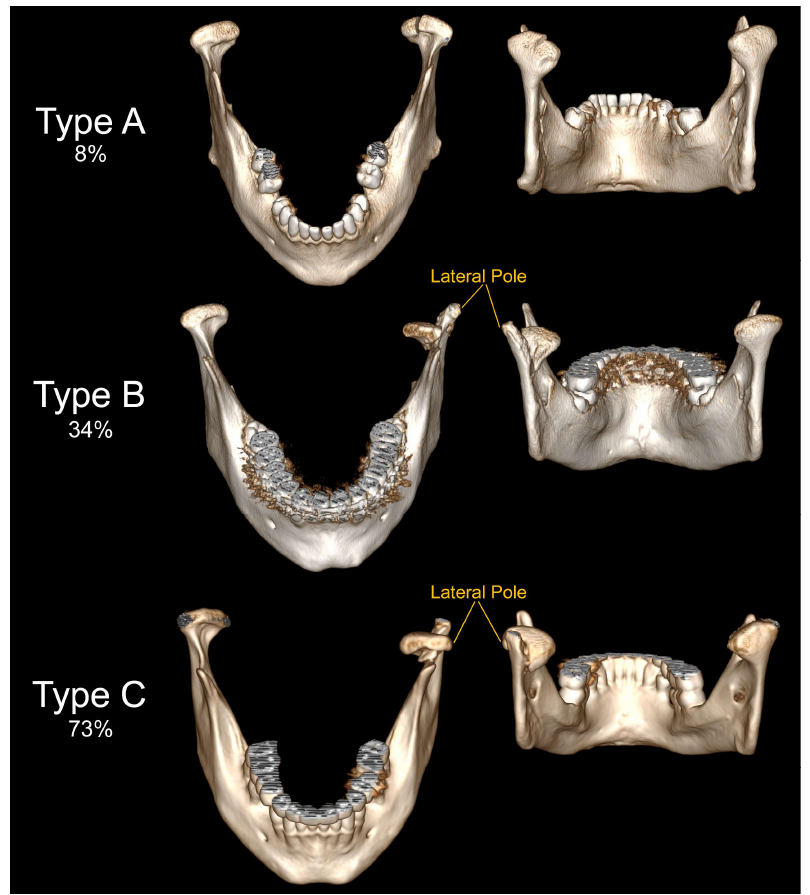
Figure 6. Examples of fractures of the mandibular head observed in the collected clinical material. The fracture occurs in the picture above within the left condylar process. Classification according to Neff: Type A—the fracture line runs through the articular cartilage close to the medial pole of the mandibular head (observed in 8% of mandibular head fractures); Type B—the fracture line runs just at the medial pole of the mandibular head (in this case, the lateral pole is not damaged) (observed in 34% of mandibular head fractures); Type C—the fracture line runs just below the lateral pole of the mandibular head (the lateral pole is detached to the distal fragment and is displaced with the entire mandibular head forward and downward) (observed in 73% of mandibular head fractures).